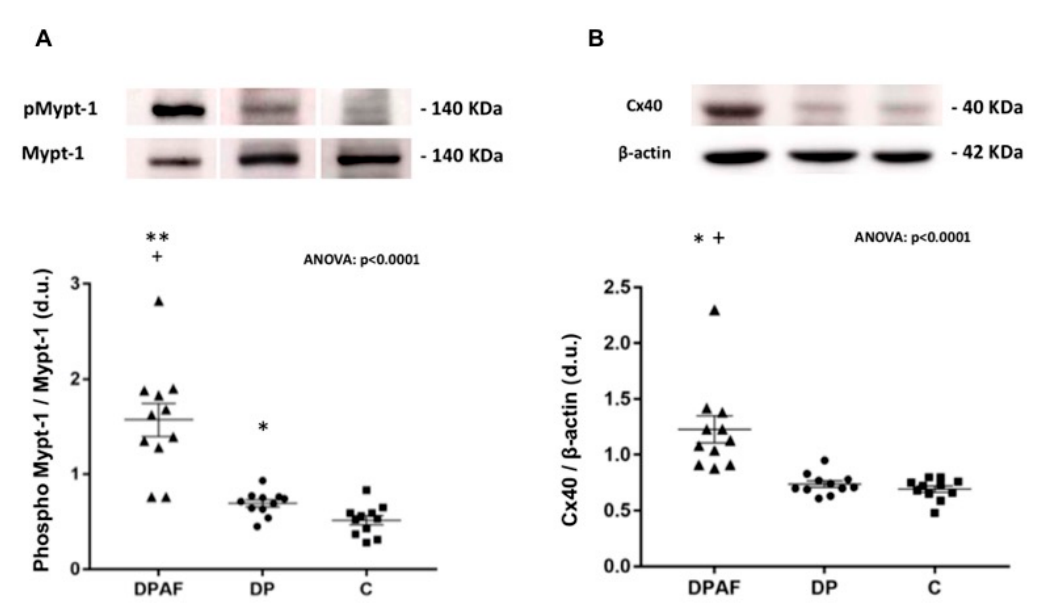
Figure 1. ( A ) Densitometric analysis of phospho-MYPT-1 (myosin-phosphatase-target subunit-1) to MYPT-1 ratio in mononuclear cells of dialyzed patients with atrial fibrillation (DPAFs) ( n = 11), dialyzed patients without AF (DPs) ( n = 11), and healthy subjects (C) ( n = 11). The top of the figure shows representative phosphorylated phospho-MYPT-1 and MYPT-1 western blot products from one DPAF, one DP, and one healthy control subject. **: p < 0.0001 vs. DP; + : p < 0.0001 vs. C; *: p = 0.009 vs.